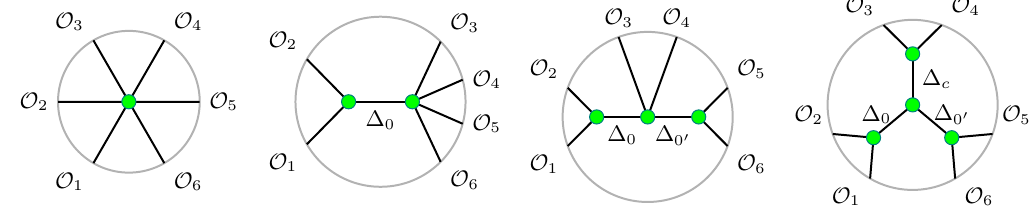
Figure 5. Inequivalent (up to relabelling) six-point tree-level diagrams which admit a direct channel CBD in the conformal basis of the OPE channel six-point block of section 4.